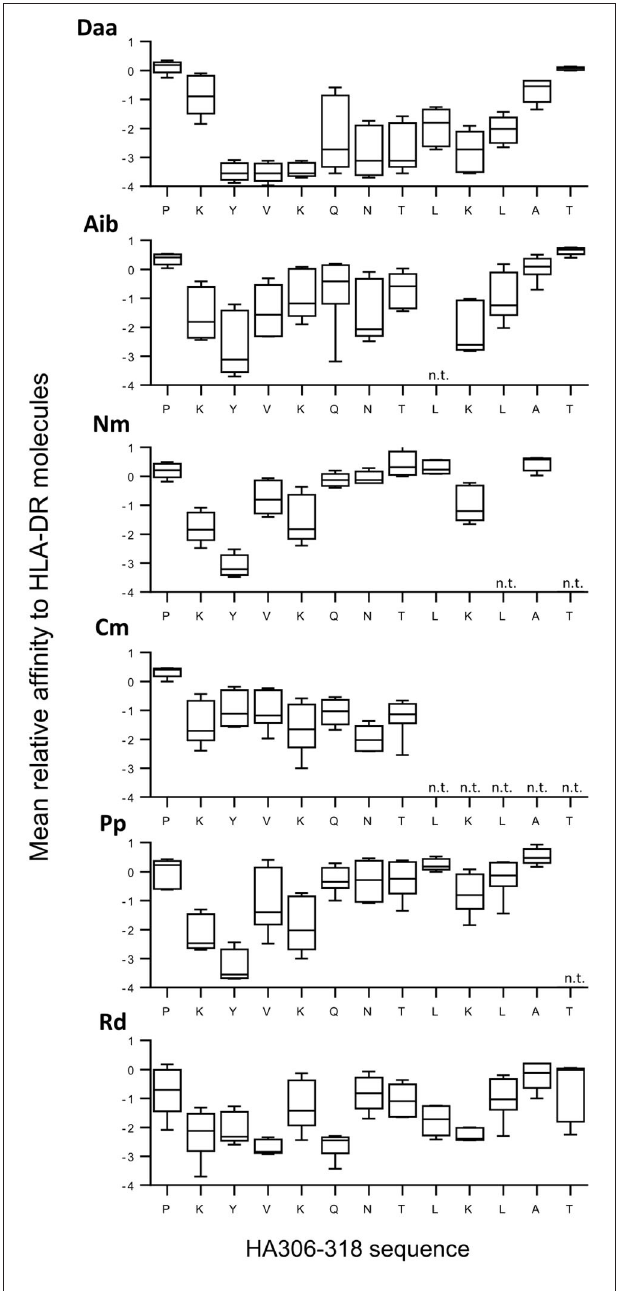
FIGURE 3 | Binding of modified HA analogs to five common human leukocyte antigen (HLA)-DR molecules. HA and 69 analogs were submitted to competitive ELISA specific for the HLA-DR molecules (DRB1*01:01, 04:01, 07:01, 11:01, and DRB5*01:01). Data were expressed as relative affinity for HLA-DR molecules (mean ratio of IC 50 of analog to the IC 50 of the HA peptide). Boxes extend from the 25th − 75th percentiles, the line in the middle of the box is plotted at the median and the whiskers go down to the smallest value and up to the largest. n.t., not tested.